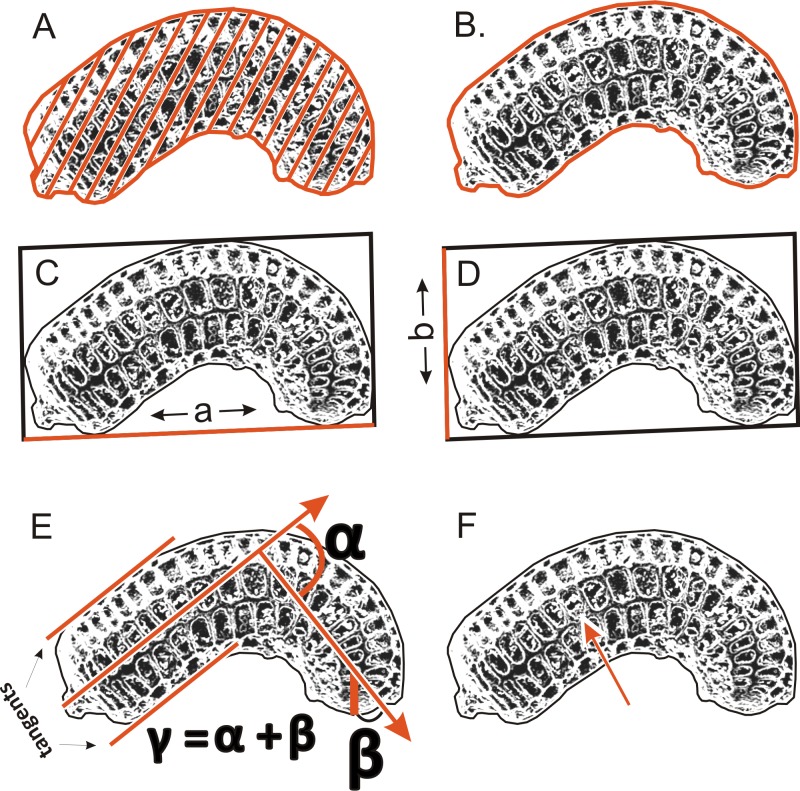
The method of measuring of seed.(A) surface; (B) profile; (C) rectangle a; (D) rectangle b; (E) the angle of curvature (γ = α + β); (F) number of pits in the middle row.